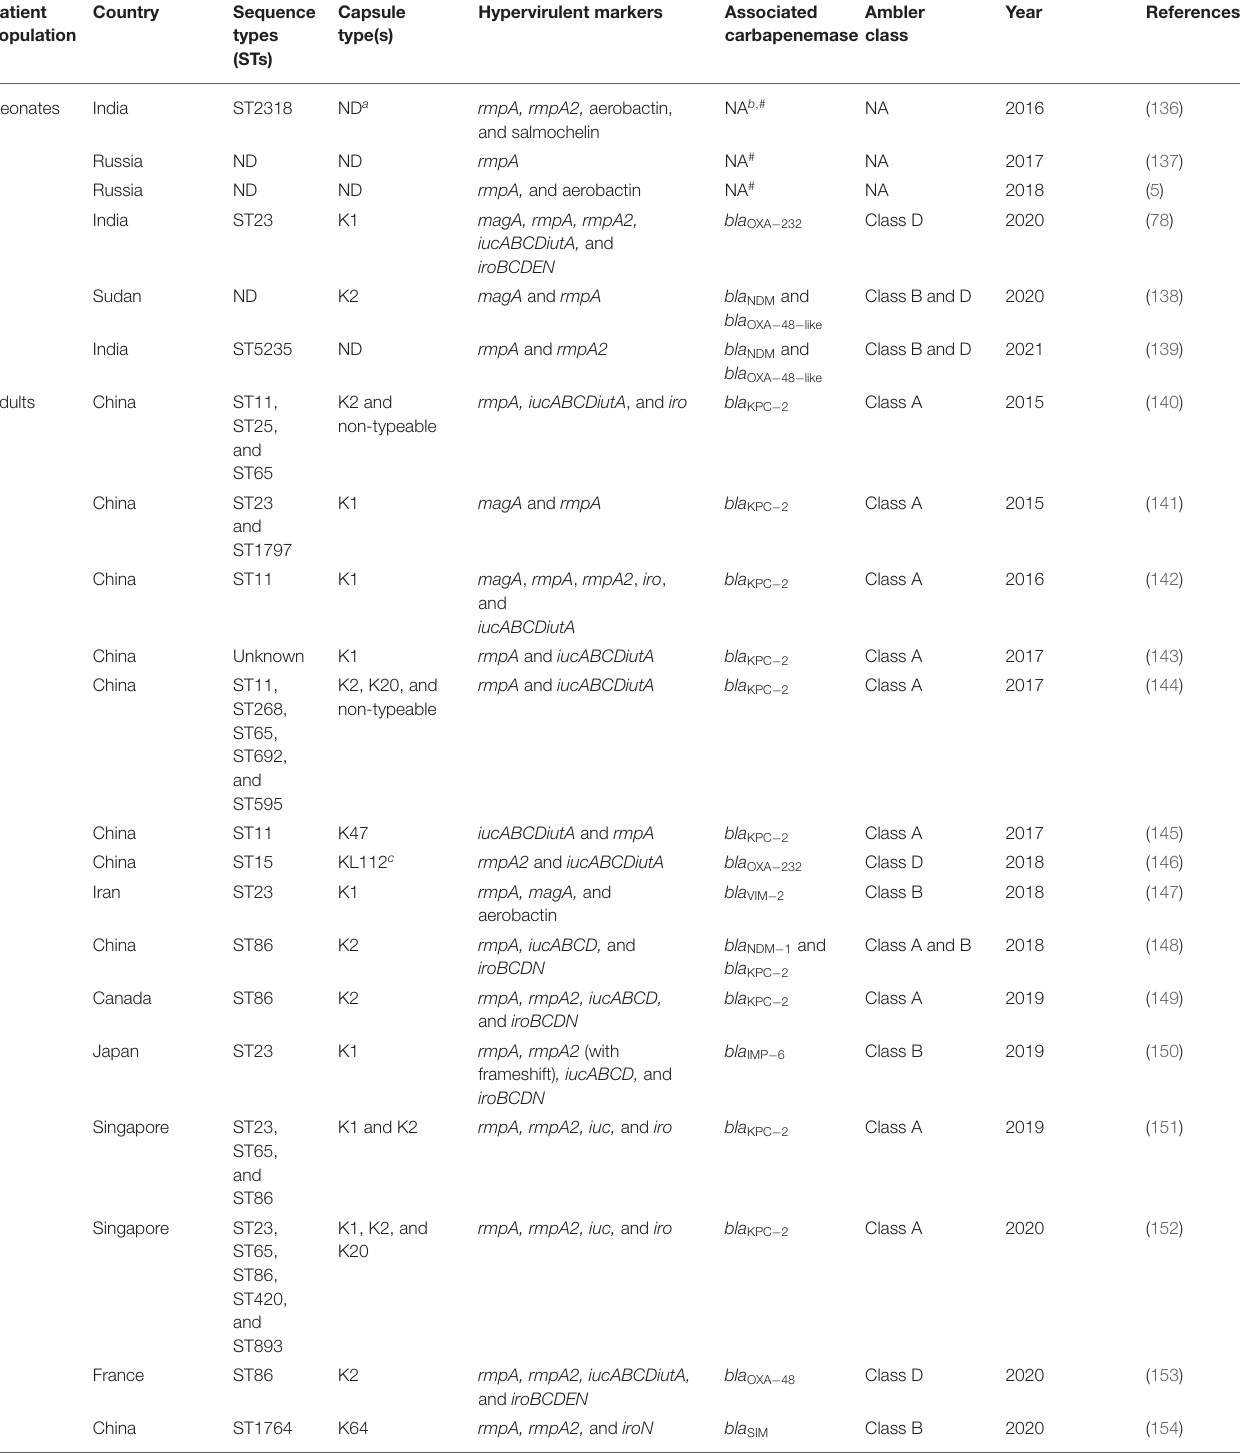
TABLE 3 | Epidemiology of some carbapenem-resistant hypervirulent K. pneumoniae (CR-hvKP)